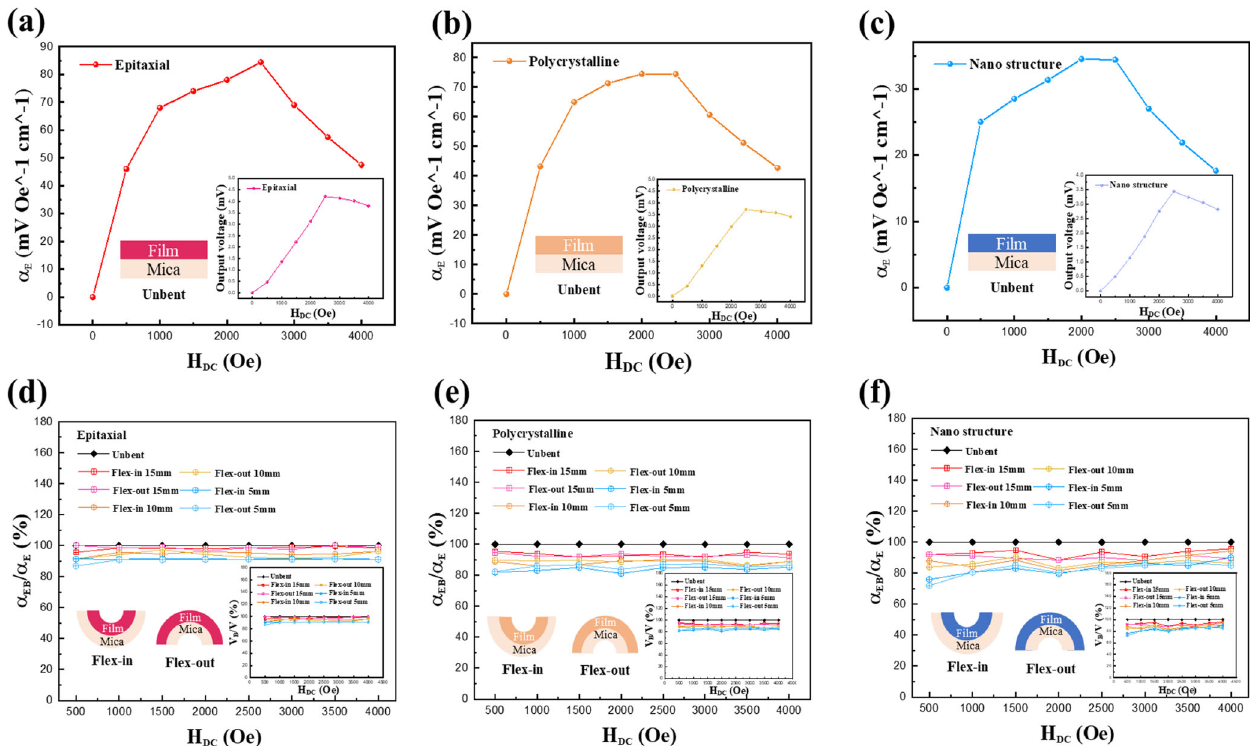
Fig. 4 ME coupling effect measurement with reliable and bending tests. a – c α E , the corresponding output voltage in three heterostructures, and the increasing DC magnetic fi eld. d – f Deviation for epitaxial, polycrystalline, and nanostructure samples under compressive and tensile strains from the bending radius of 15 mm to 5